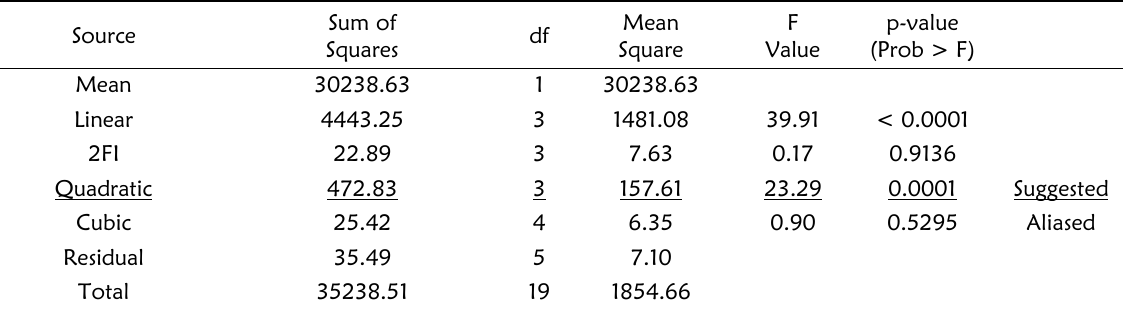
Table 5: Fit summary statistics for wear rate